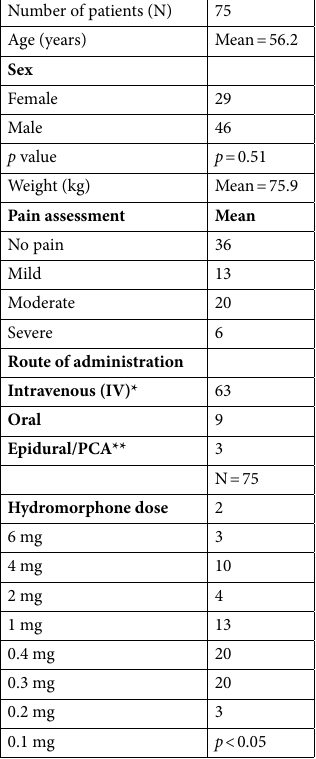
Table 2. Characteristics of subjects who received naloxone therapy. *Intravenous route. * *Patient-controlled analgesia.